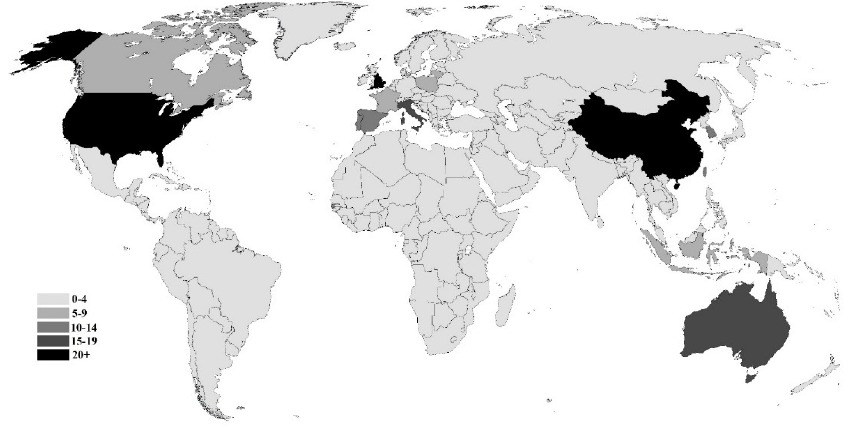
Figure 3. Geographical distributions of publications (source: created by the